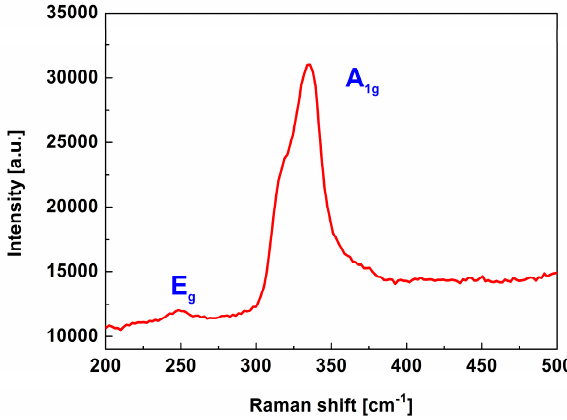
Figure 2. Raman spectrum of ZrS 2 nanostructured film.